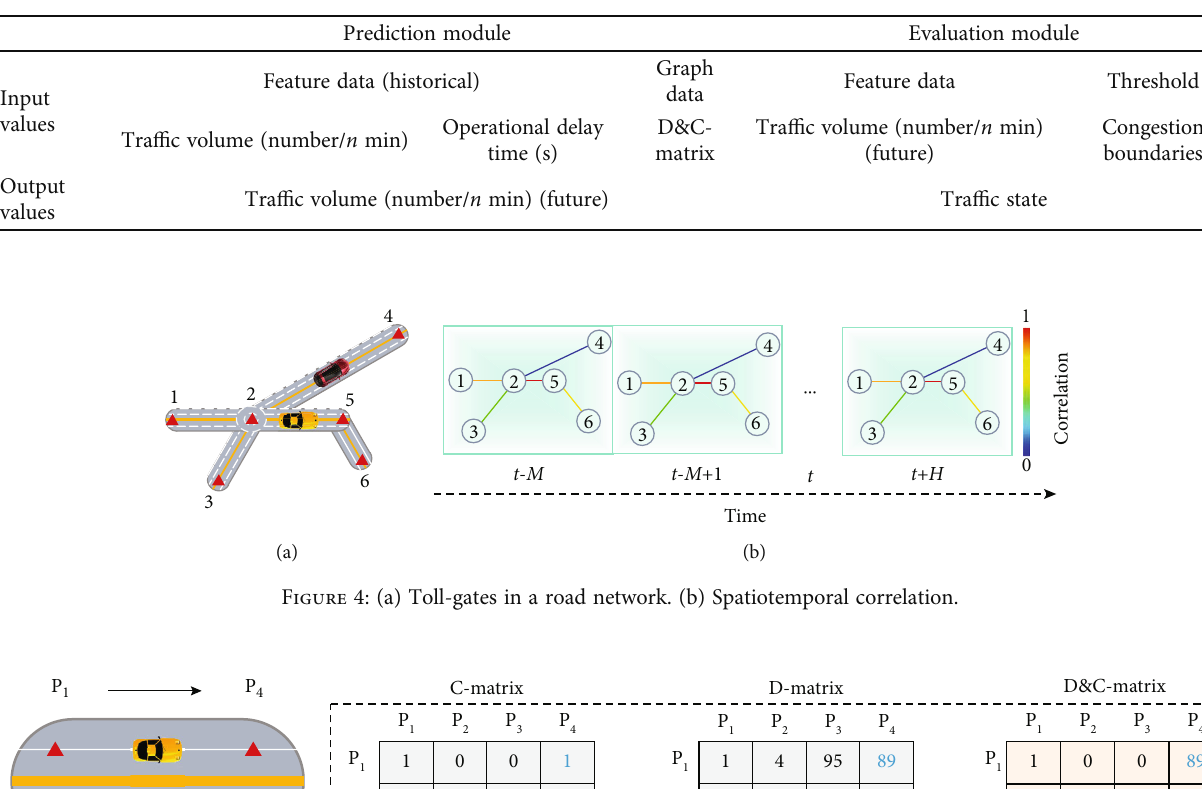
Table 1: The input/output values of the proposed model.